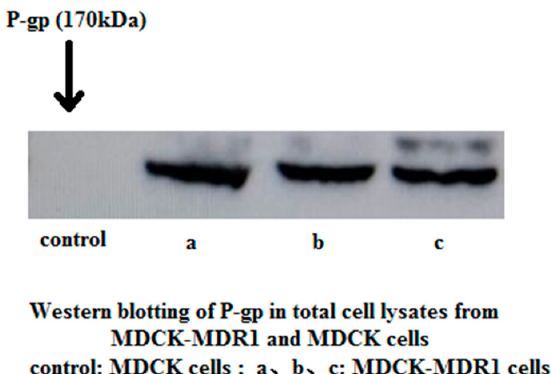
Figure 1. Comparison of the expression of P-gp in MDCK-MDR1 and MDCK native cells.